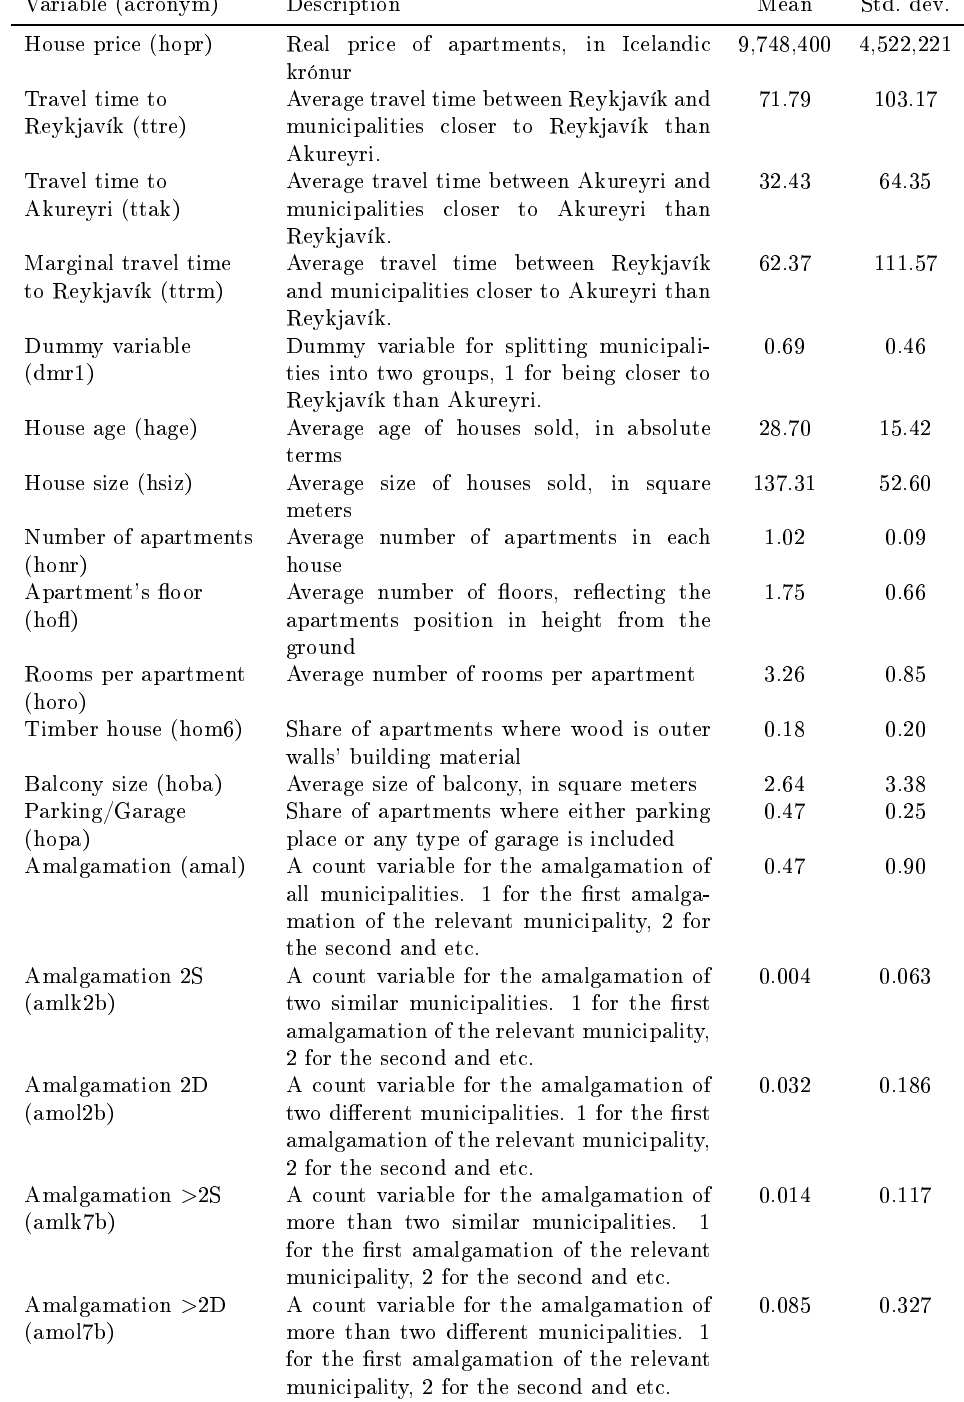
Table 2: Variable description and sample